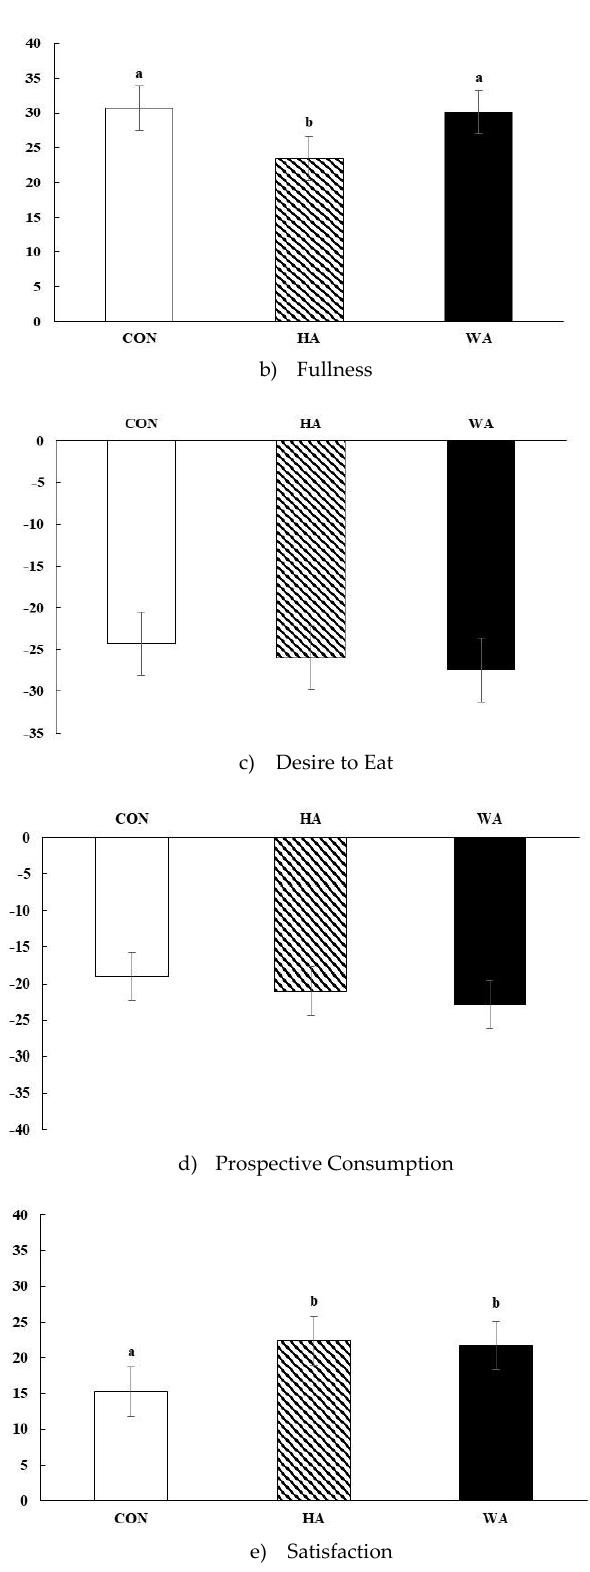
Figure 3. Mean changes in Visual Analogue Scale (VAS) scores as a measure of subjective satiety after meals: ( a ) hunger, ( b ) fullness, ( c ) desire to eat, ( d ) prospective consumption, ( e ) satisfaction after consumption of CON, Control meal; HA, Half Hass avocado meal; or WA, Whole Hass avocado meal. Main e ff ects of meal p < 0.05 indicated by di ff erent letters, time p < 0.0001, and meal × time p NS. N =